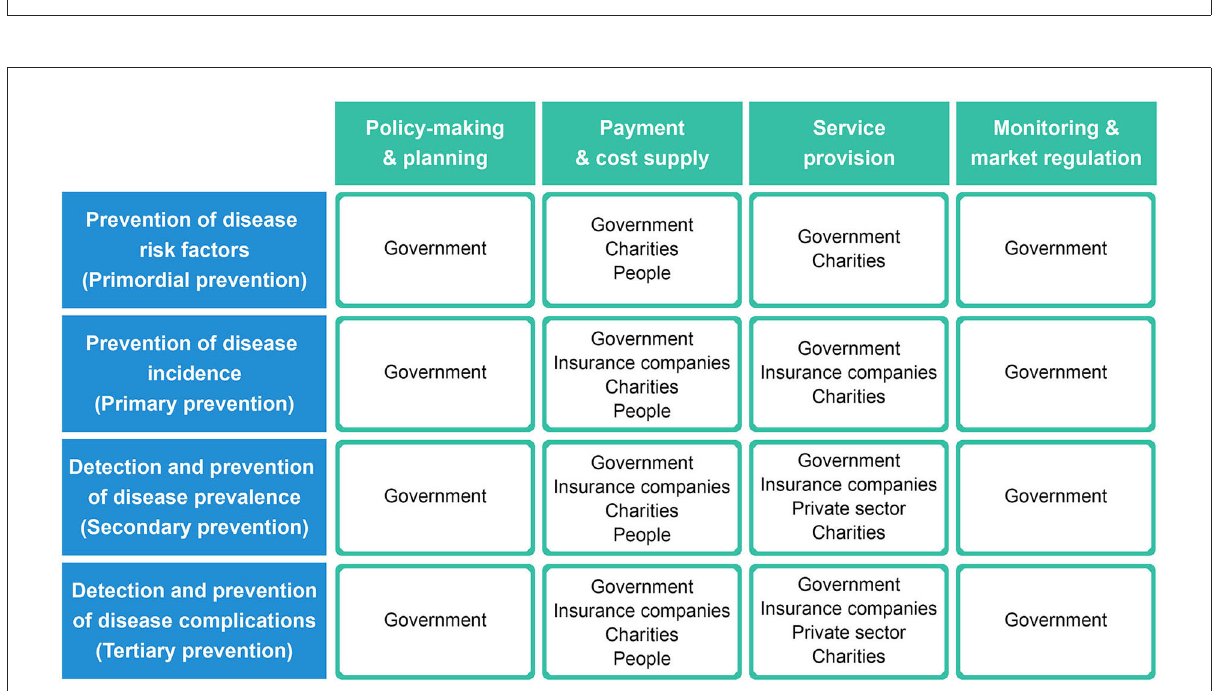
FIGURE2 A simplified framework showing how system actors are tasked with different functions of the system process (rows) in each core domain (columns). Each cell represents a subsystem that is assigned to the specific actor(s)